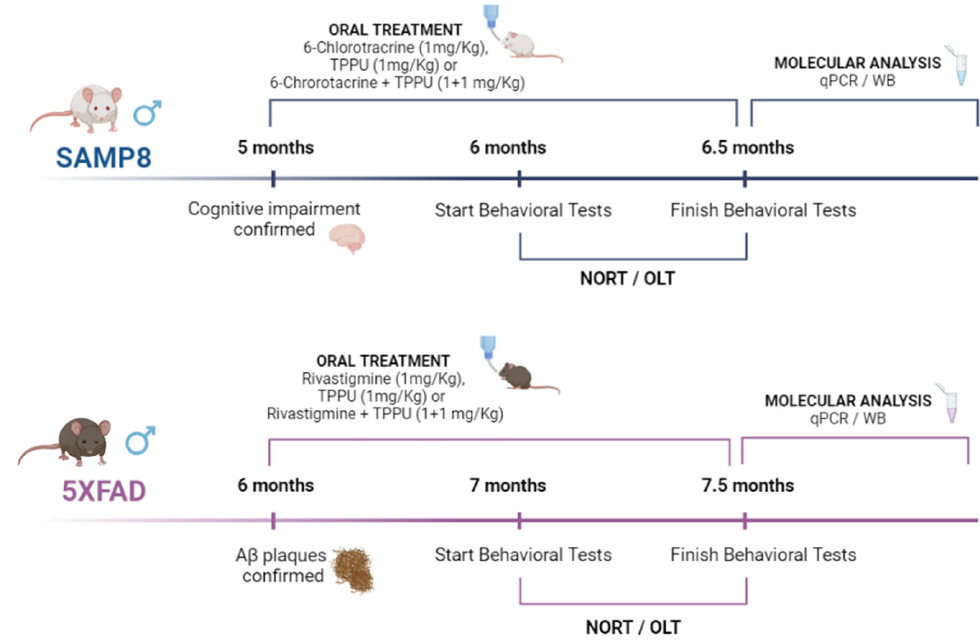
Figure 7. Experimental design scheme. SAMP8 control; SAMP8 treated with the TPPU (1 mg/kg/day); SAMP8 treated with 6 ‐ Cl ‐ THA (1 mg/kg/day), SAMP8 subjected to co ‐ treatment with TPPU (1 mg/kg/day) plus 6 ‐ Cl ‐ THA (1 mg/kg/day). 5XFAD control; 5XFAD treated with TPPU (1 mg/kg/day), 5XFAD treated with Riv (1 mg/kg/day); 5XFAD subjected to co ‐ treatment with TPPU